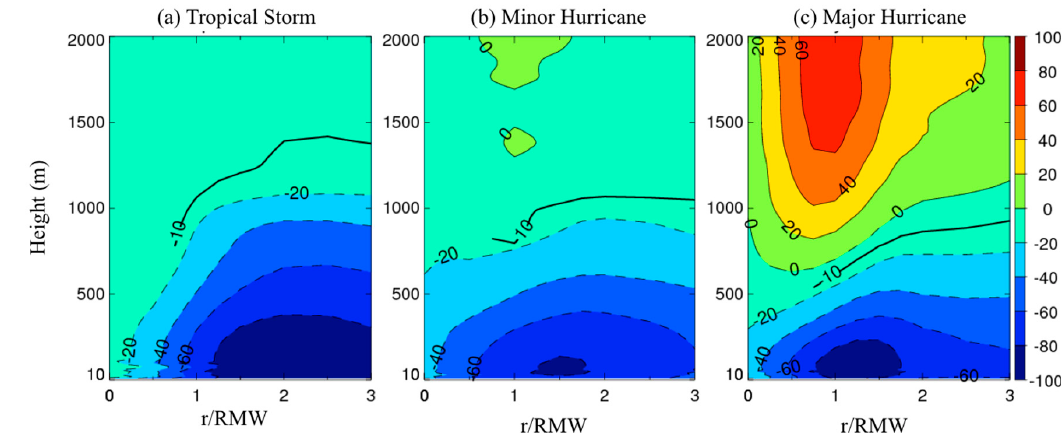
Figure 6. Composite analysis of the radial wind velocity normalized by the peak values in percentage (%) as a function of altitude and normalized radius for ( a ) tropical storms, ( b ) minor hurricanes, and ( c ) major hurricanes.